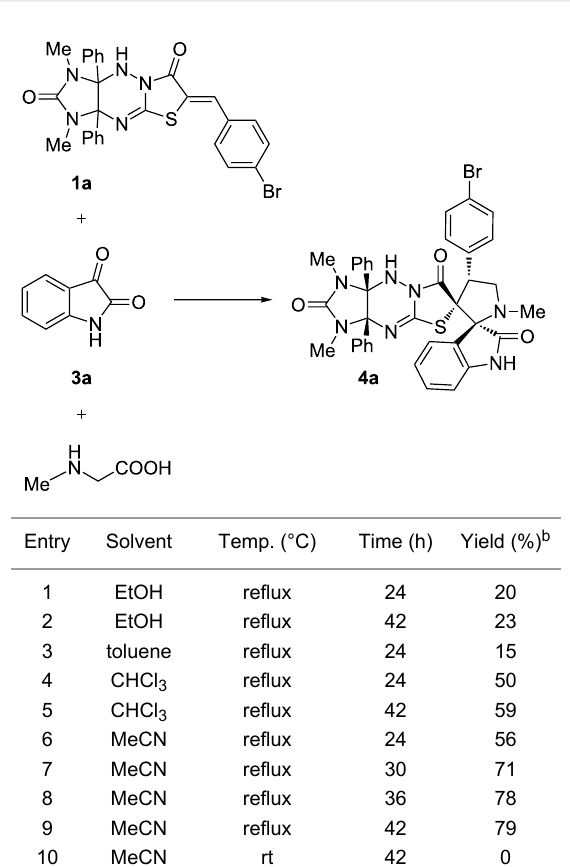
Table 1: Optimization of the 1,3-dipolar cycloaddition reaction condi- tions.